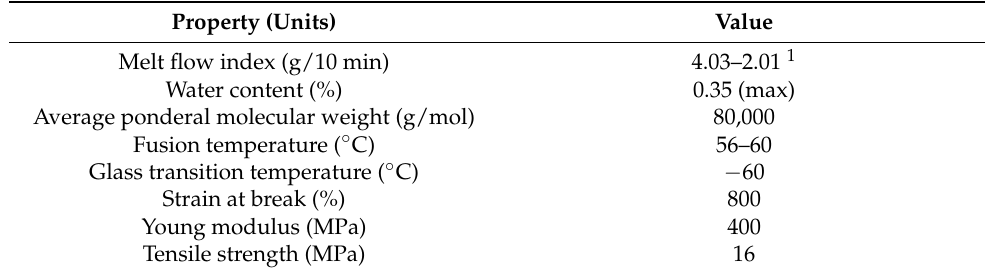
Table 1. Properties of PCL, according to the